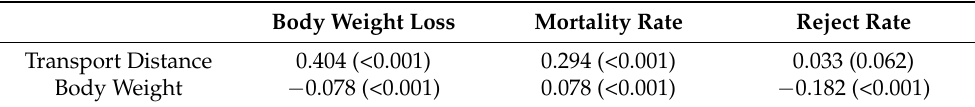
Table 5. Spearman correlation coefficients between different variables ( r ( p